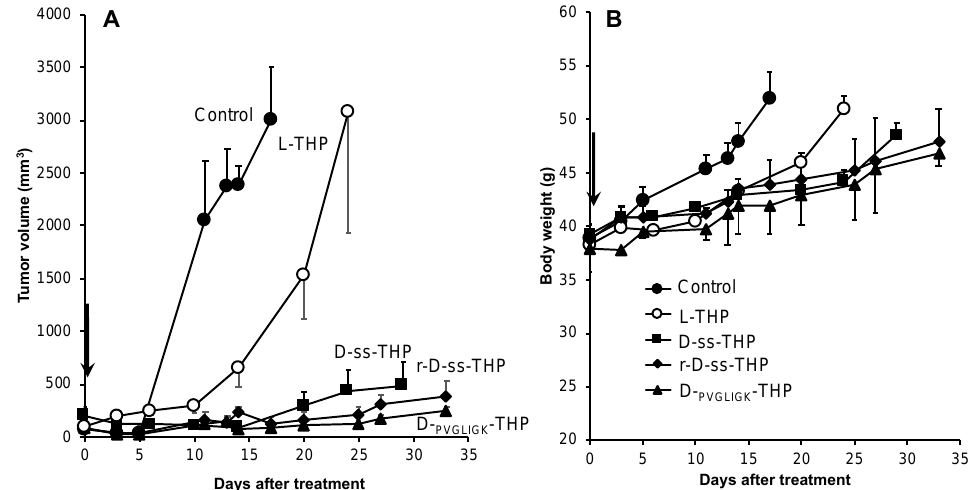
Figure 9. In vivo antitumor activities of P-THP conjugates. In S180 solid tumor model, when tumors reached 8 – 10 mm in diameter, P-THP conjugates were injected i.v. at the dose of 5 mg/kg (THP equivalent). Tumor sizes ( A ) as well as body weight of the mice ( B ) were measured every 2 – 3 days during the experiments. Arrow indicates the treatment of P-THP conjugates. Data are mean ± SE. See text for details.